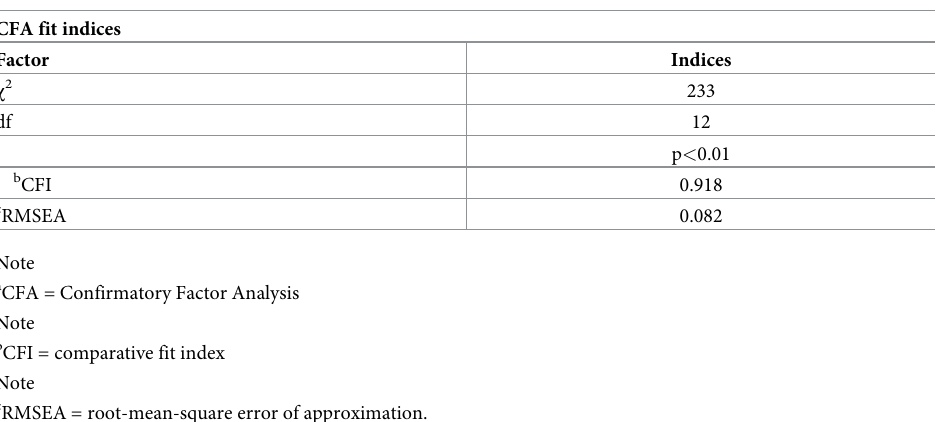
Table 3. CFA fit indices a .